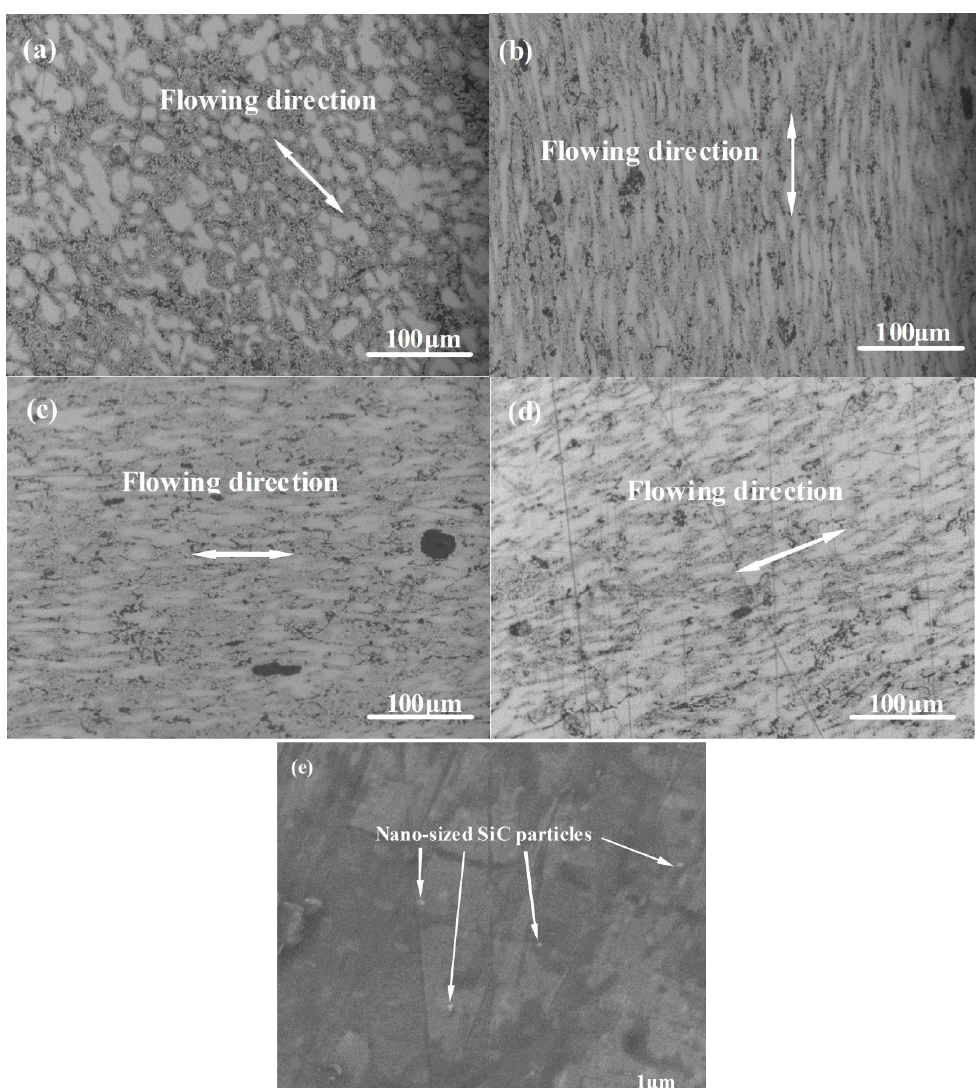
Figure 5. Microstructure in different locations of the thixoformed part of the nano-sized SiCp/7075 composite soaked for 10 min at 590 °C: ( a ) Optical microscopy (OM) image in location A; ( b ) OM image in location B; ( c ) OM image in location C; ( d ) OM image in location D and ( e ) scanning electron microscopy (SEM) image in location C.